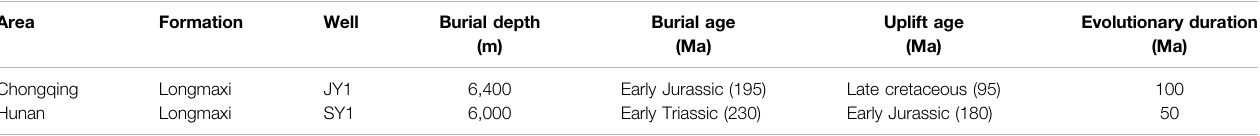
TABLE 3 | Tectonic subsidence and uplift time of the Longmaxi Formation in Chongqing and Hunan. Some data of the Longmaxi shale in Chongqing and Hunan from Jin et al. (2018), Wan et al. (2017), and Zhai et al. (2017).